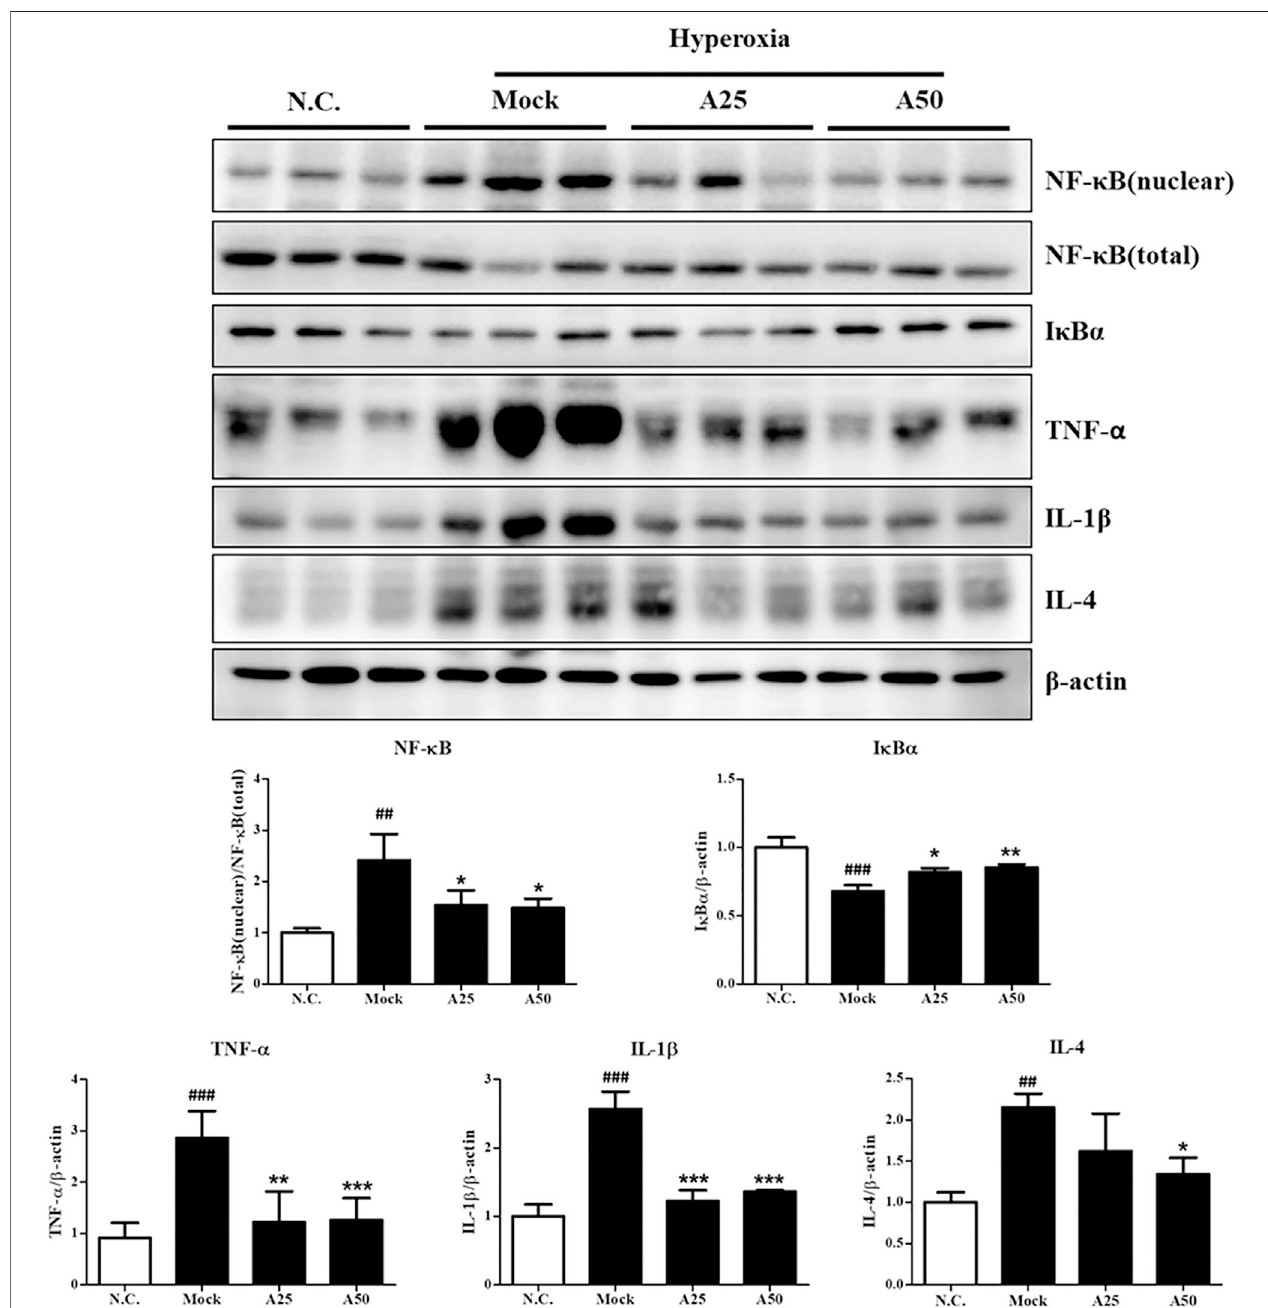
FIGURE 5 | Therapeutic ef fi cacy of aspirin in inhibiting hyperoxia-induced in fl ammation in the lung tissue of NF- κ B-luciferase +/+ transgenic mice. The bands were quanti fi ed relative to β -actin bands using ImageJ software. The values are reported as the means ± SEM ( n (cid:1) 6 mice per group). # p < 0.05, ## p < 0.01, and ### p < 0.001 compared with the N.C. group; * p < 0.05 and ** p < 0.05 compared with the Mock group. N.C, treatment with PBS at 0, 24, and 48 h and exposure to normoxia; Mock, treatment with PBS at 0, 24, and 48 h and exposure to hyperoxia for 72 h; A25, treatment with 25 μ g/g aspirin at 0, 24, and 48 h and exposure to hyperoxia for 72 h; A50, treatment with 50 μ g/g aspirin at 0, 24, and 48 h and exposure to hyperoxia for 72 h.